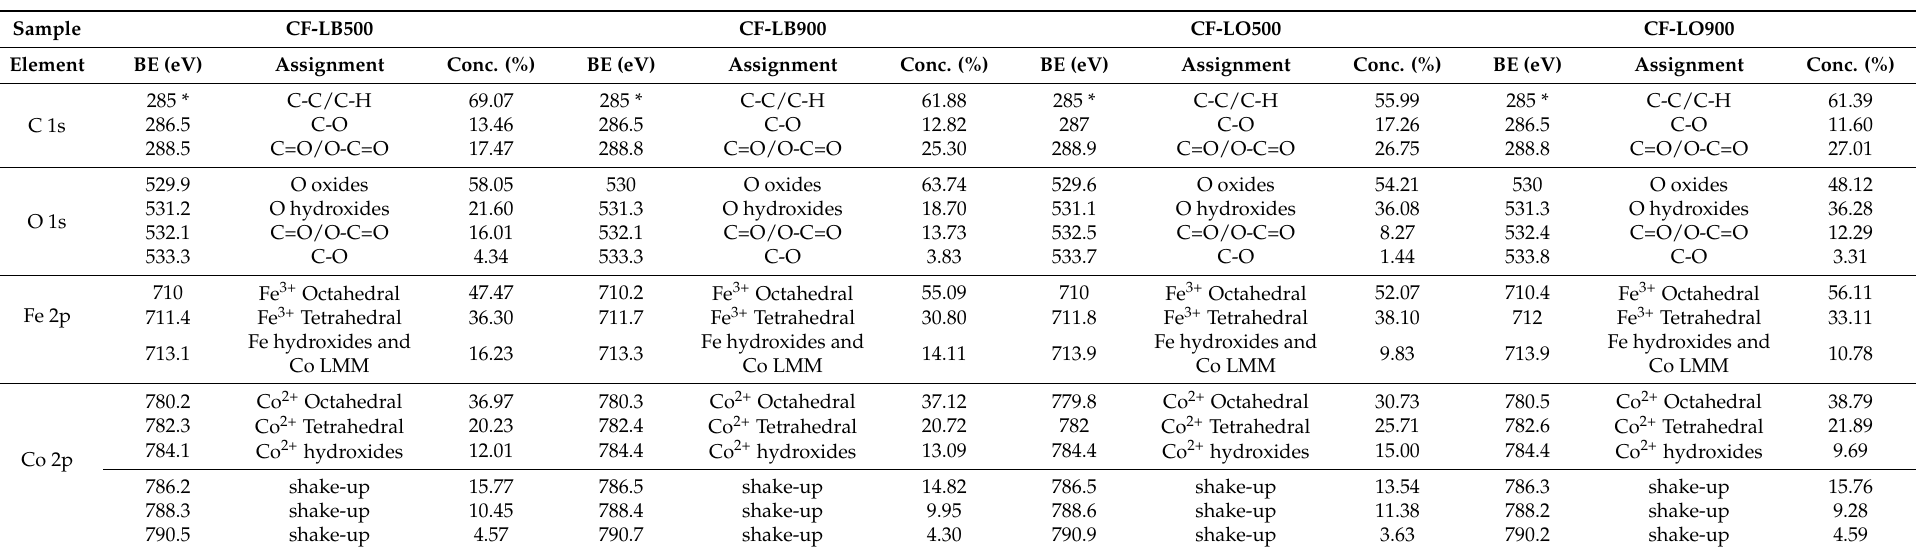
Table 3. Detailed XPS data for ferrite-lignin